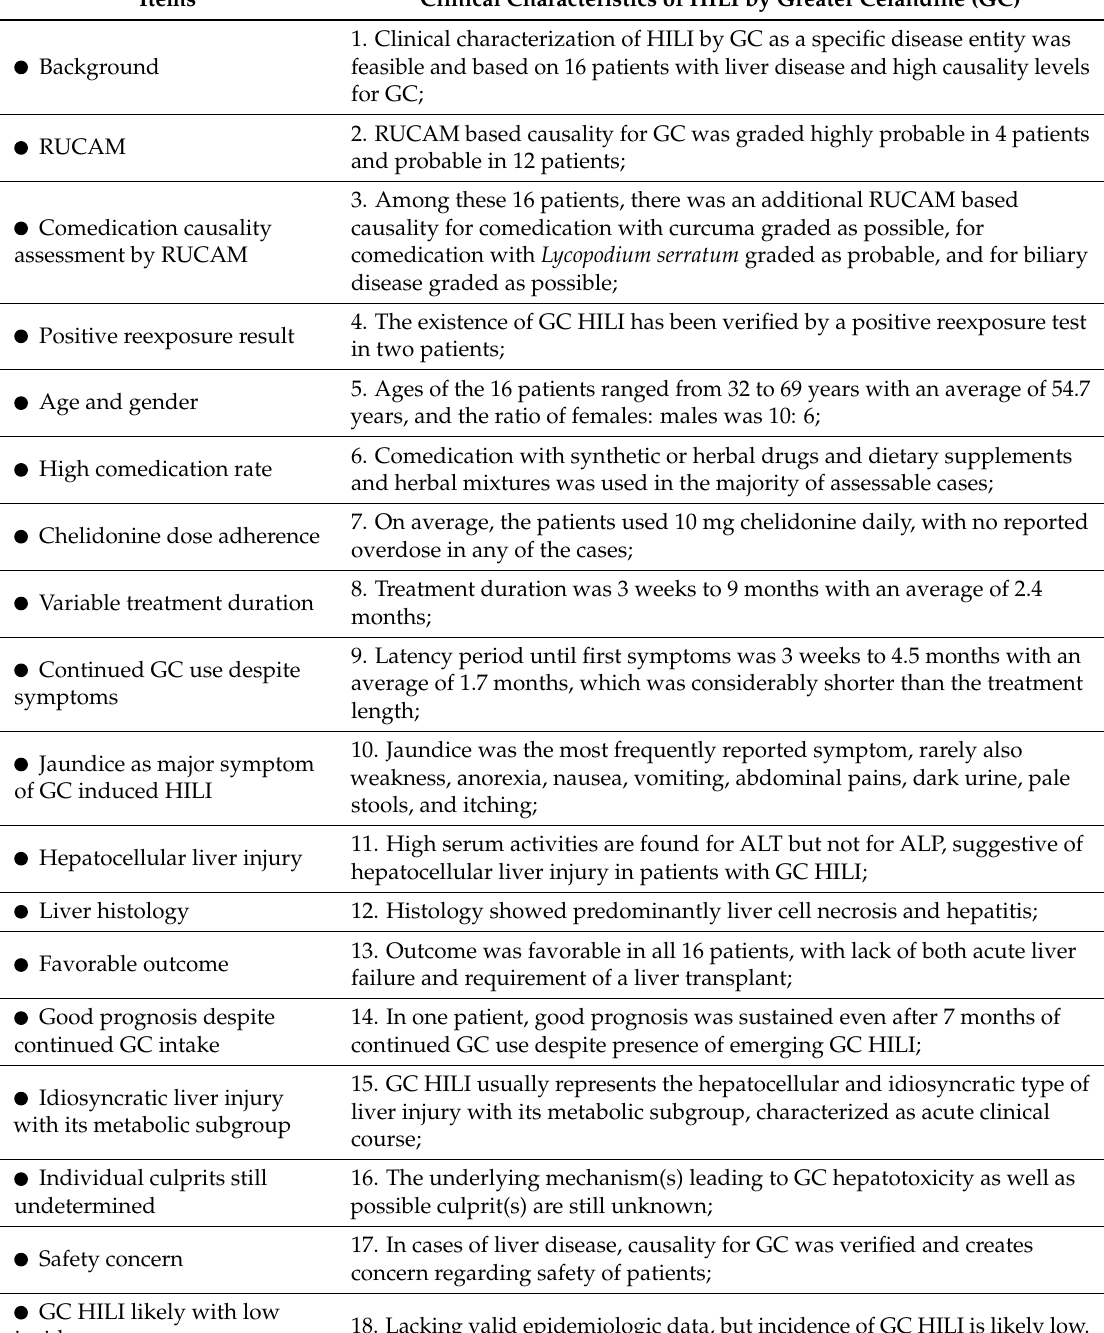
Table 3. Clinical characteristics of HILI by Greater